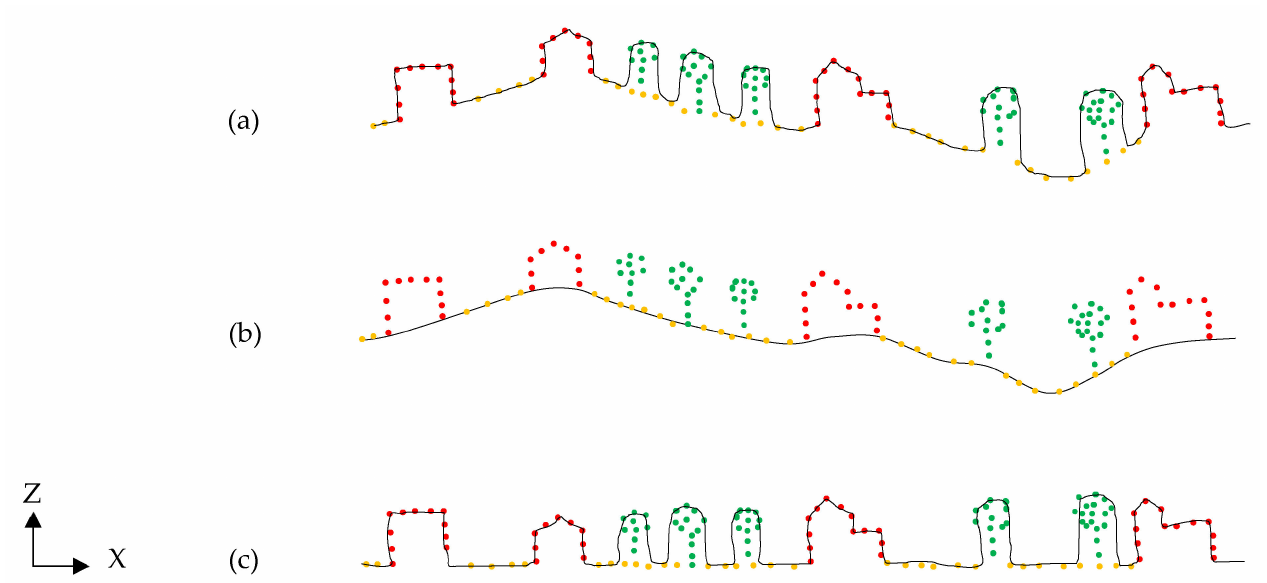
Figure 2. Schematic diagram to show the difference between: ( a ) DSM (Digital Surface Model), ( b ) DEM (Digital Elevation Model), and ( c ) The nDSM (normalized Digital Surface